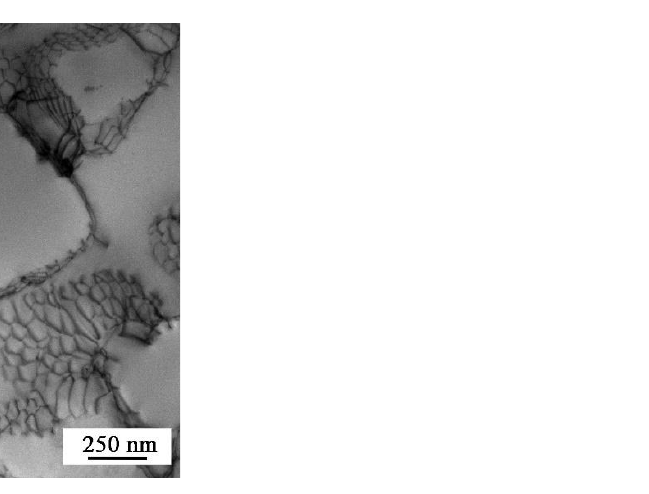
Figure 10. TEM images of dislocation arrangement after TMF tests under IP loading ( a ) 300 – 900 °C ( b , c ) 500 – 900 °C.